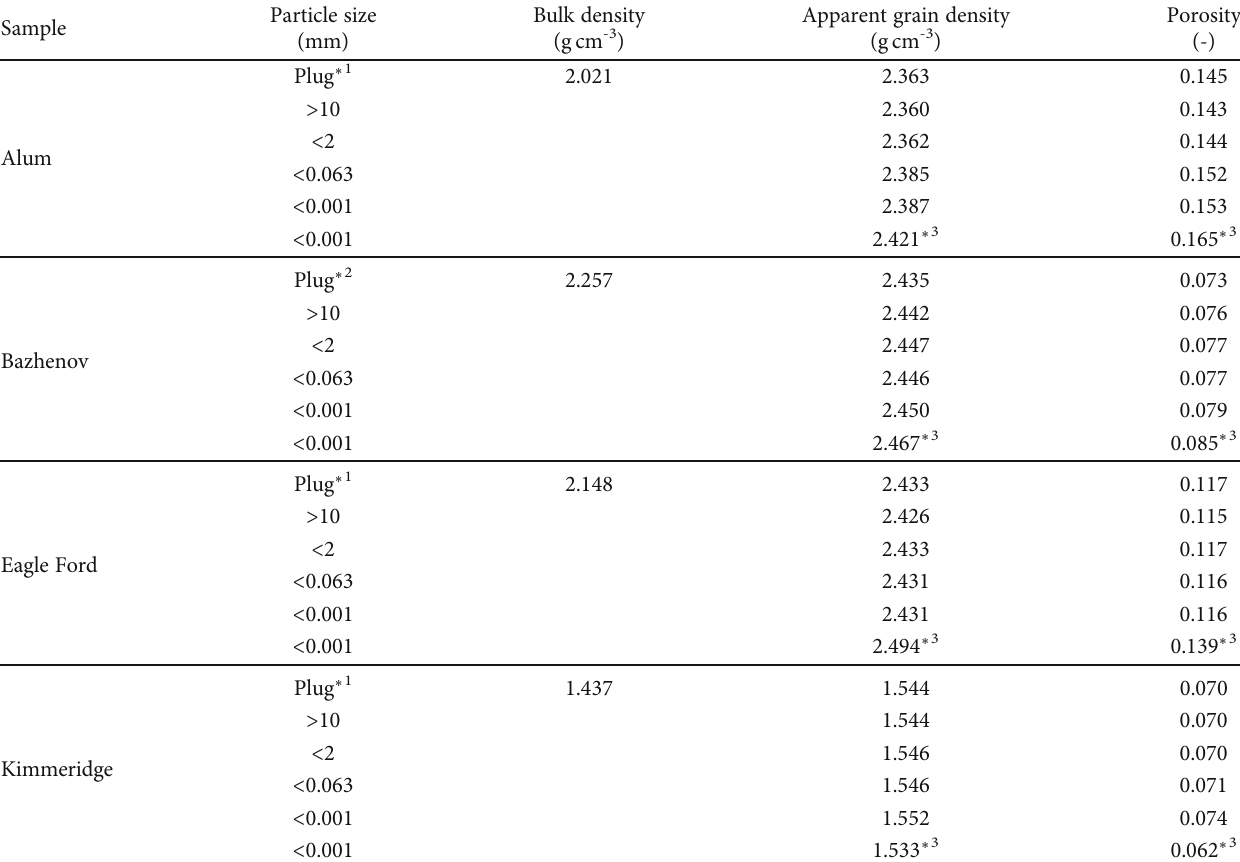
Table 3: Apparent grain densities and computed porosities as a function of particle size. Sample